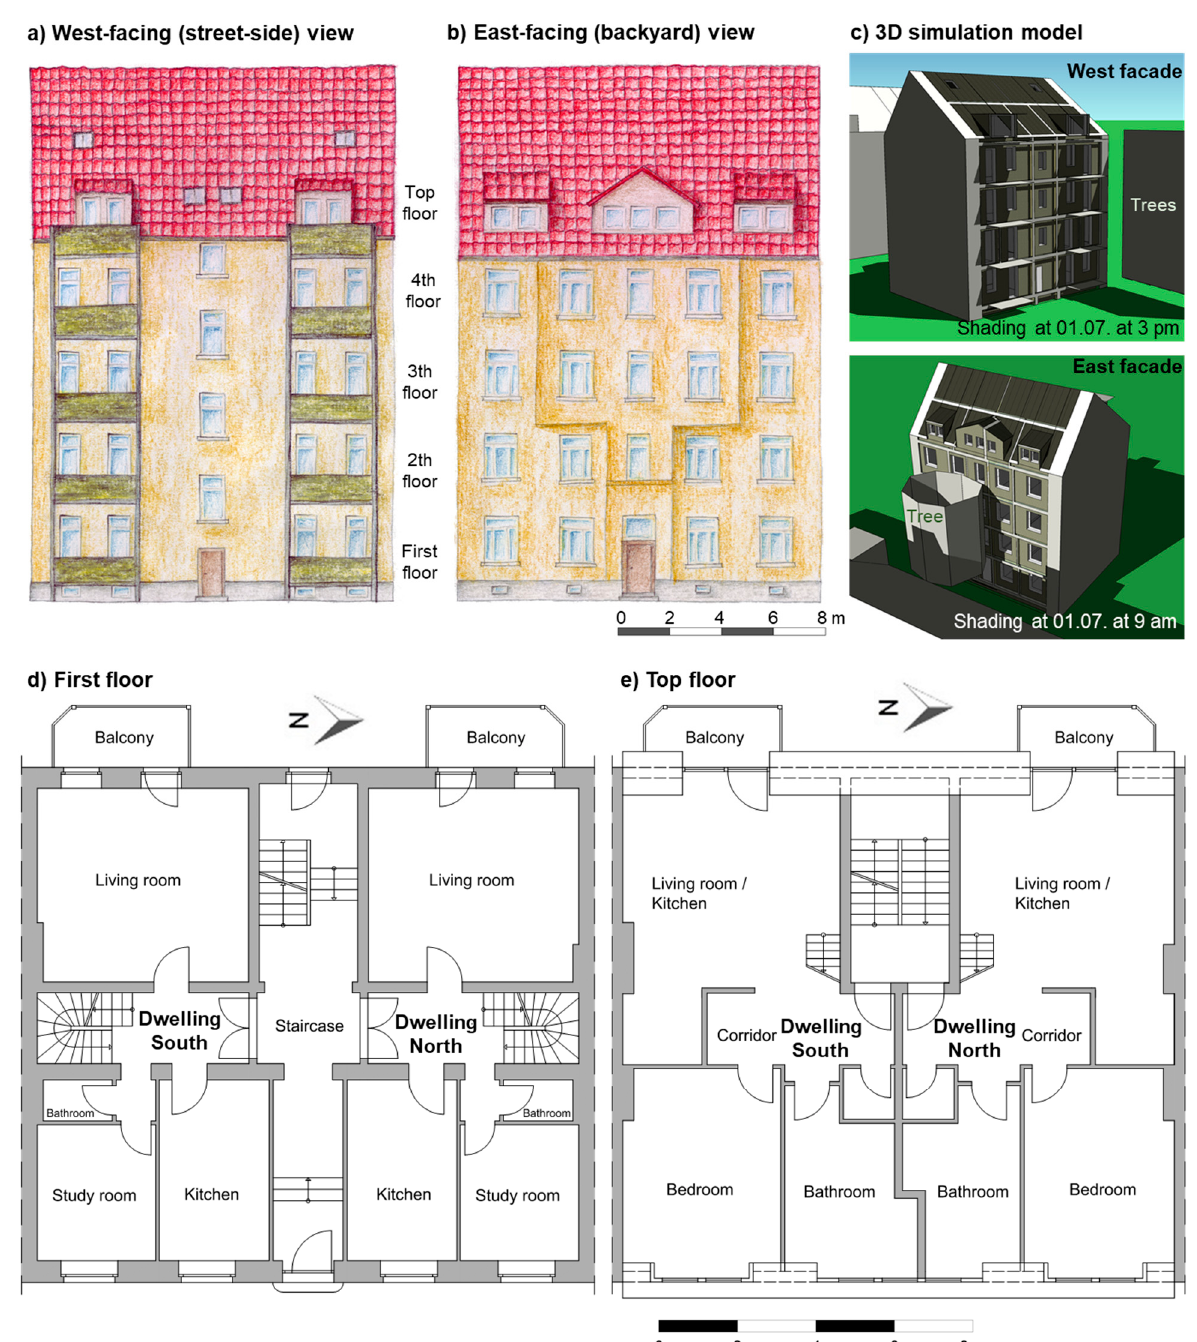
Figure 1. ( a ) West-facing backyard view, ( b ) east-facing street-side view of the investigated GZH building, ( c ) 3D simulation model with shading situations in the morning and in the afternoon, and ( d ) first/ground to ( e ) top floor plan of the GZH building.